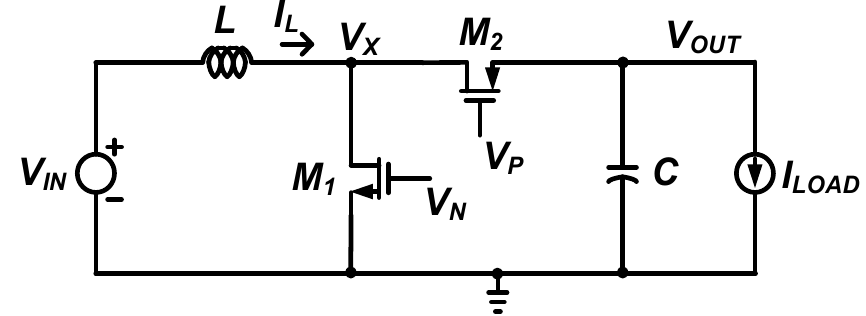
Figure 2. Schematic of an inductor-based DC-DC boost converter.